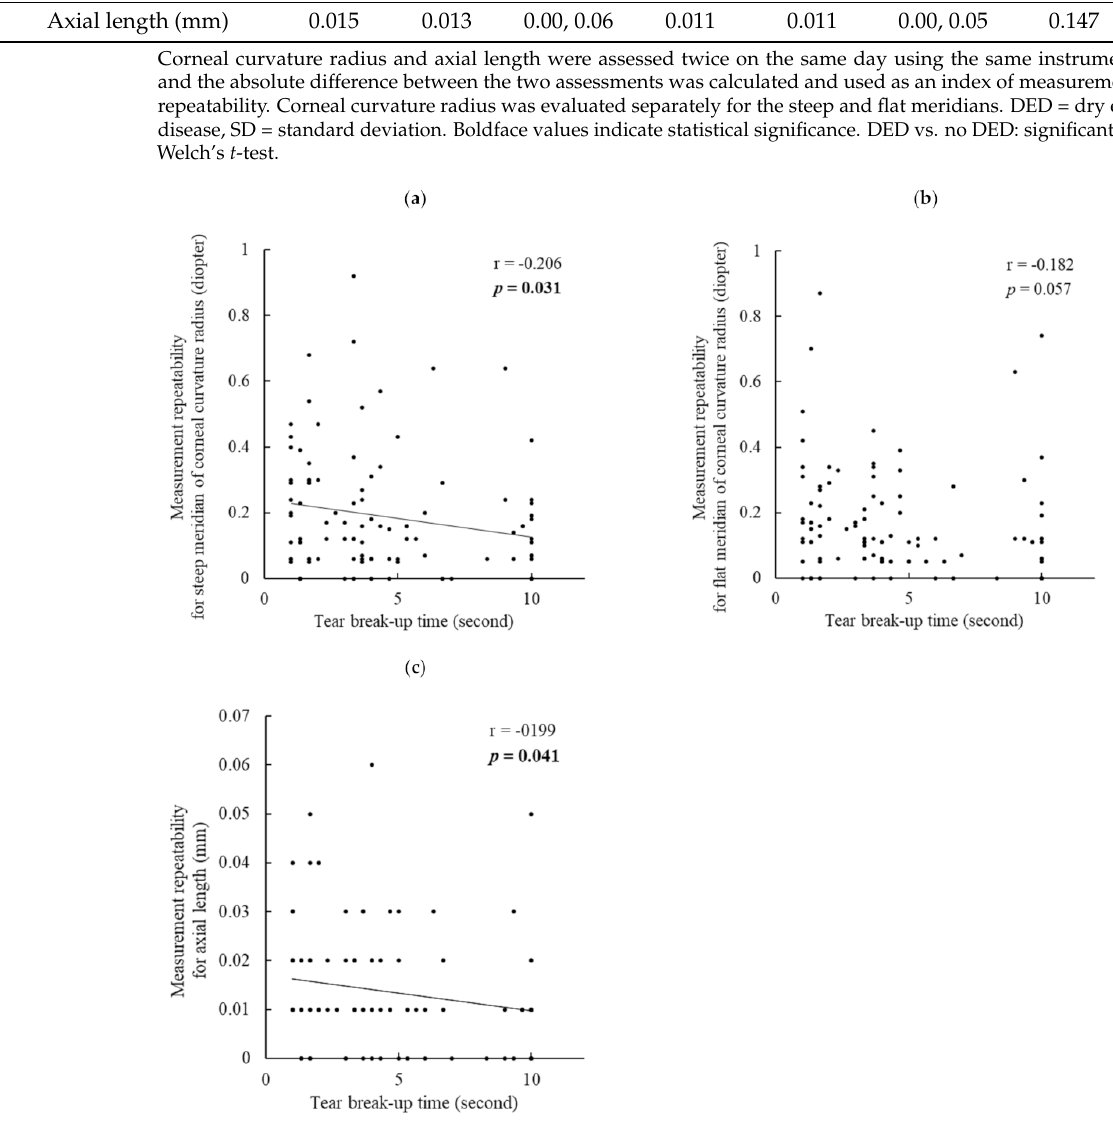
Figure 1. Correlations between tear break-up time and the measurement repeatability of corneal curvature radius and axial length: ( a ) steep meridian of corneal curvature radius, ( b ) flat meridian of corneal curvature radius, and ( c ) axial length. Tear break-up time was significantly correlated with the measurement repeatability of the steep meridian of corneal curvature radius and axial length but not with that of the flat meridian of corneal curvature radius. Boldface values indicate statistical significance. Boldface values indicate statistical significance. Correlation was evaluated using Pearson’s correlation